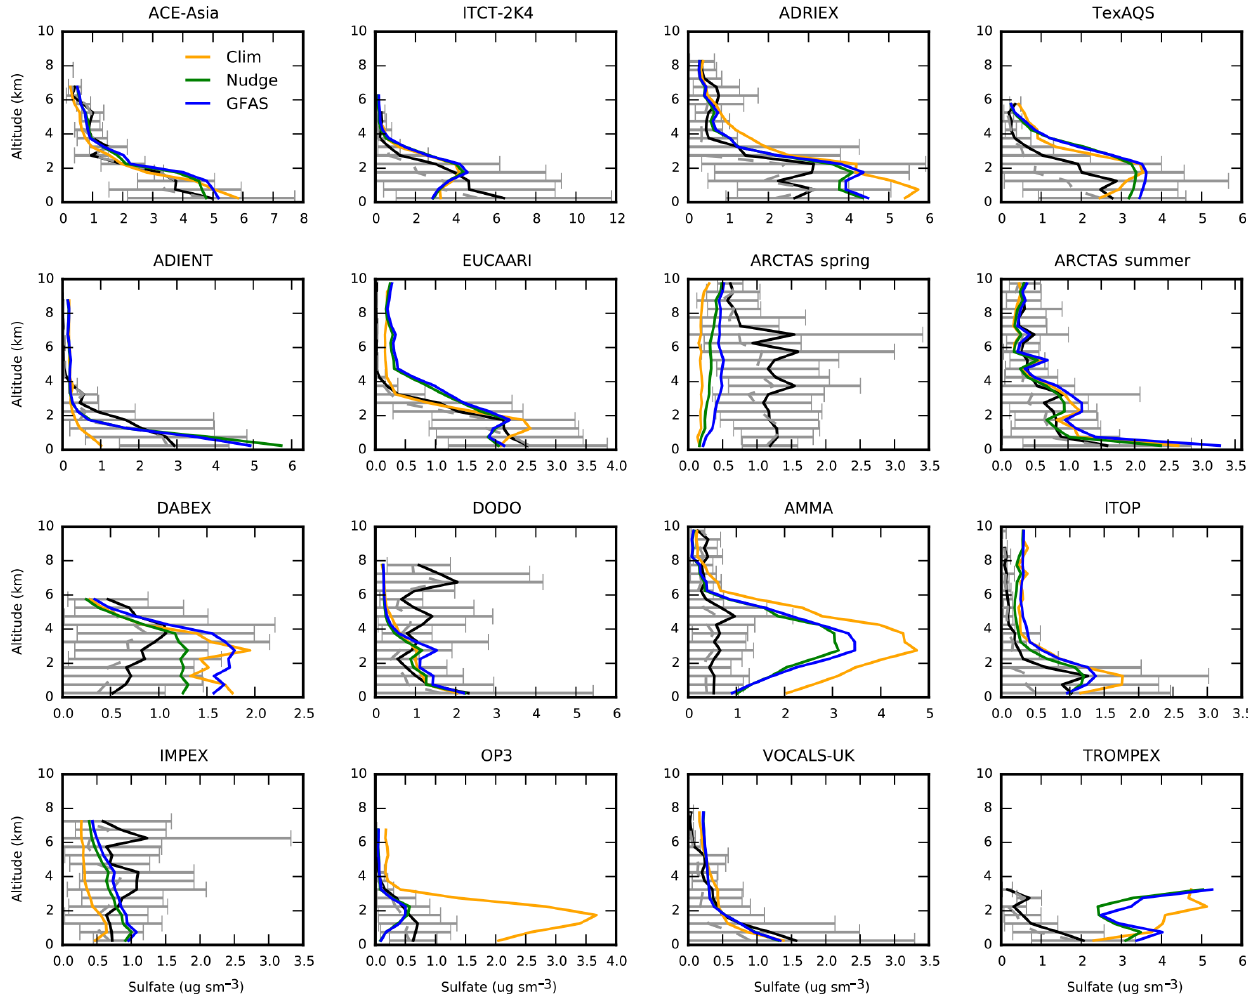
Figure 12. Vertical profiles of observed concentrations of sulfate (black) and simulated concentrations from the three simulations: CLIM (orange), NUDGE (green), and GFAS (blue). The observations are provided for 16 aircraft campaigns that investigated different regions of the world from 2001 to 2009 (Heald et al., 2011) (see also Fig. 2). The model is sampled along the flight tracks using a temporal average of the outputs over the duration of the campaign, and the error bars show the variabilities in the measurements. Simulated vertical profiles are shown as monthly and regional